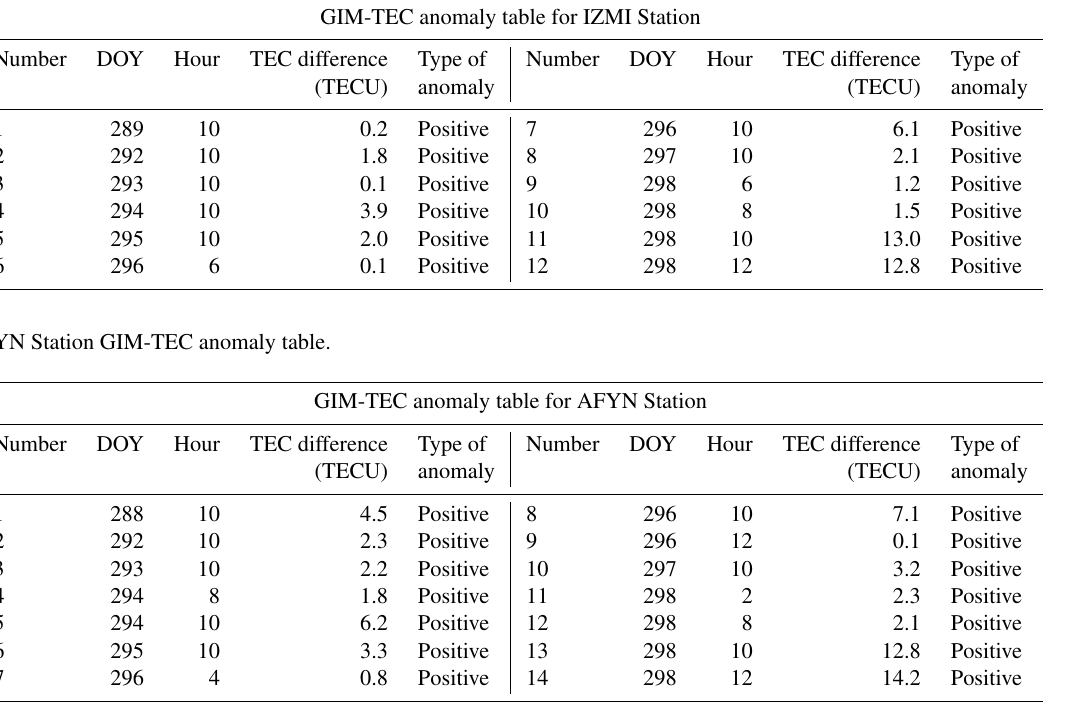
Table 3. IZMI Station GIM-TEC anomaly table.